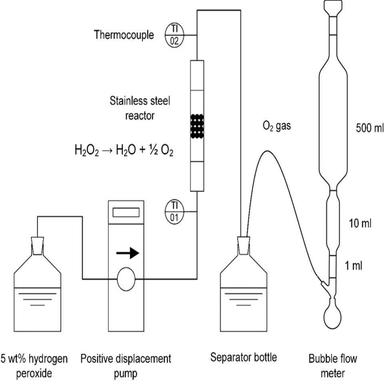
Schematic of the differential reactor setup used for catalyst testing.